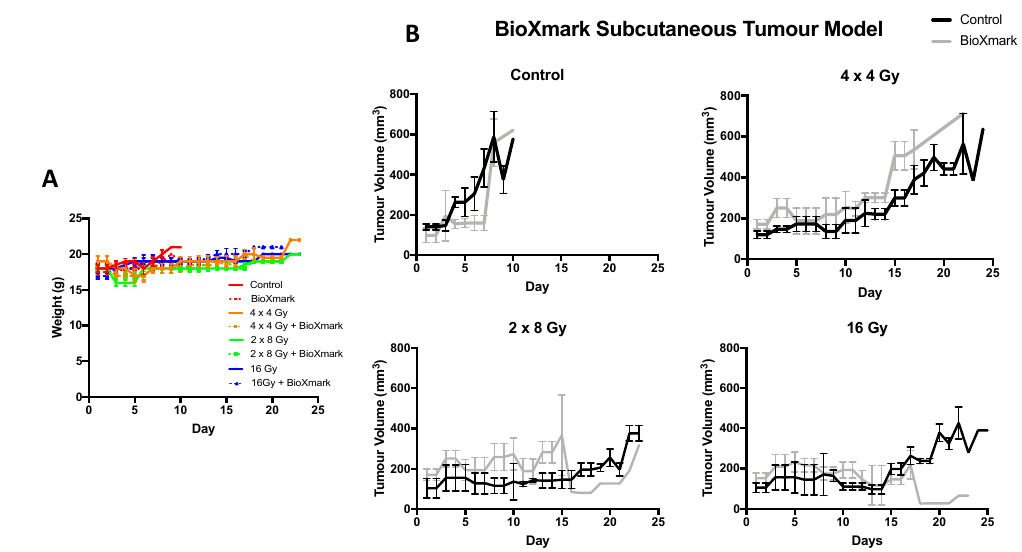
Figure 4. Impact of BioXmark ® on LLC tumour growth delay following single-fraction and fractioned radiotherapy exposures. Mice were intra-tumorally injected with 20 µL of BioXmark ® prior to irradiation. ( A ) Mean animal weight per treatment group versus time (days). ( B ) Data are presented as median tumour volume for the experimental group ± SEM versus time in days (average six mice per experimental group).